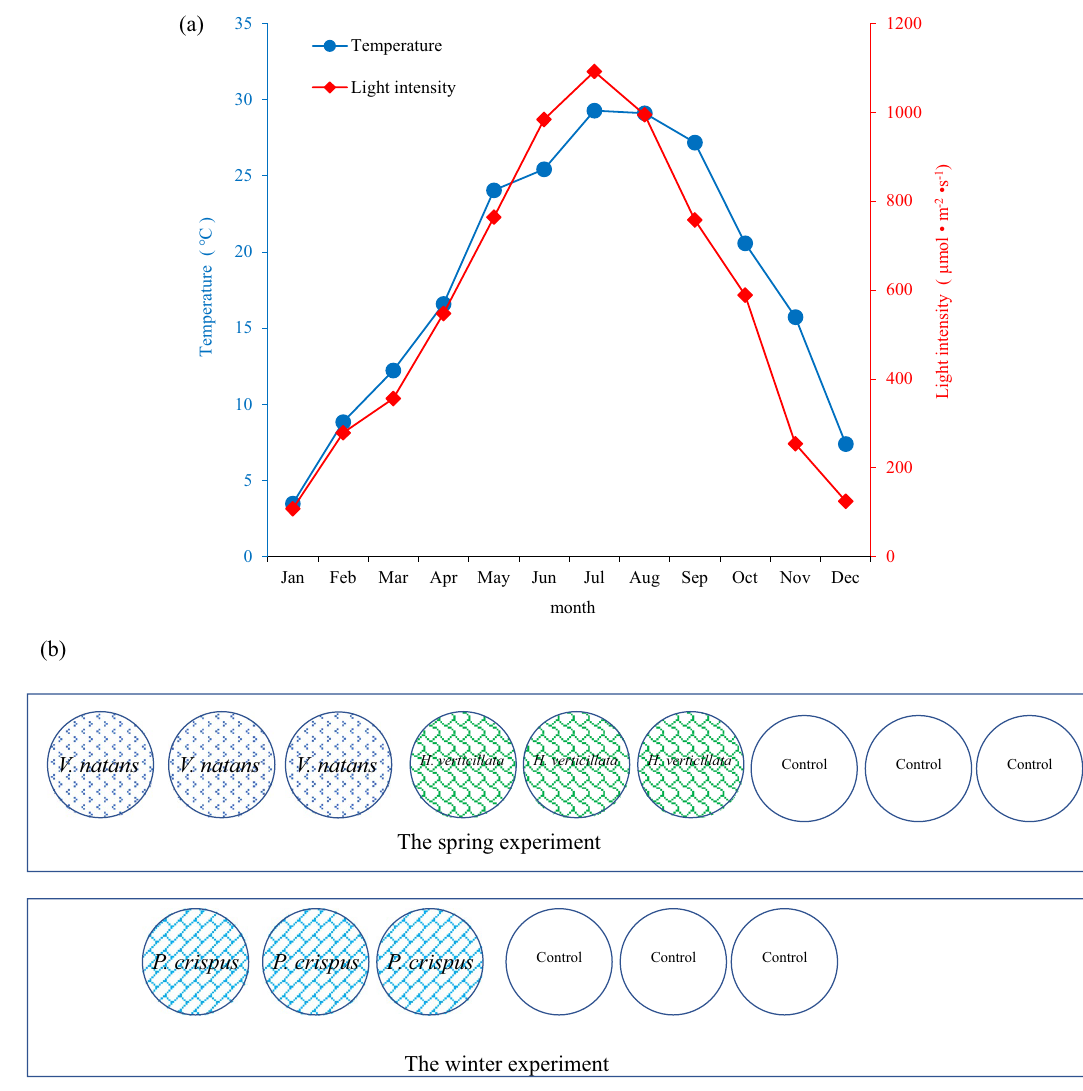
Fig. 1 Average water temperature and light intensity ( a ) of the experimental greenhouse and the graphic of the experimental design( b